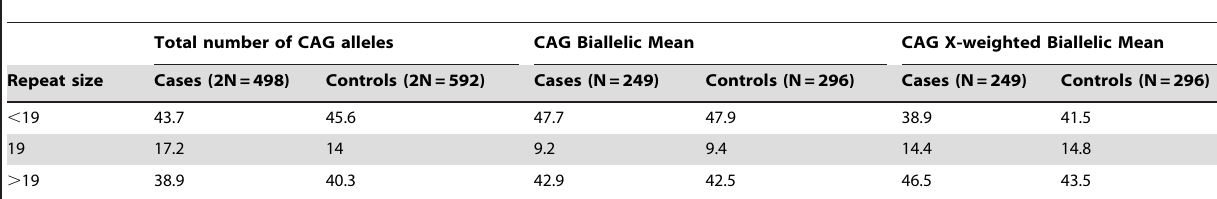
Table 1. Distribution (%) of PCOS cases and controls according to the qualitative categories of CAG repeats.